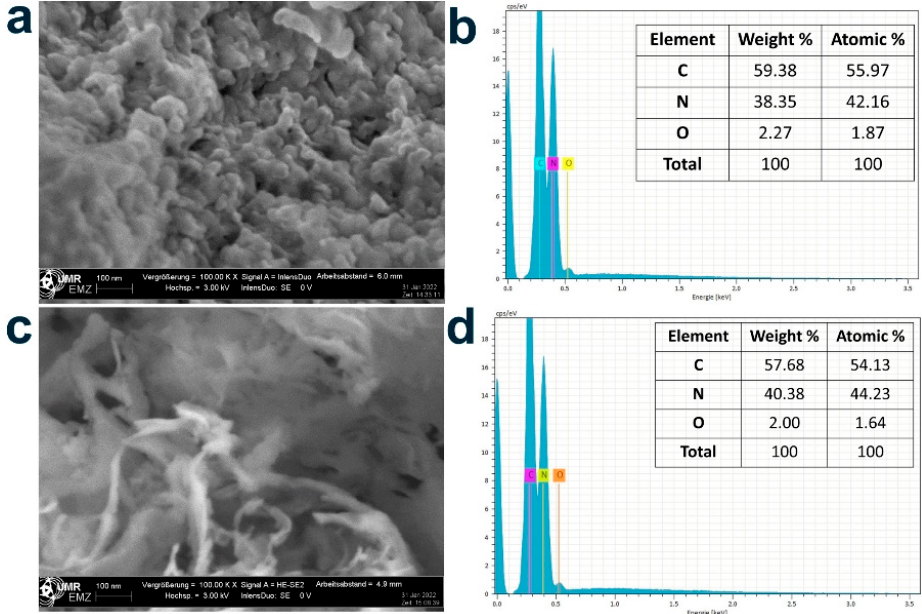
Figure 1. SEM image ( a ) and EDX analysis results ( b ) of bCN; SEM image ( c ) and EDX analysis results ( d ) of CNS.